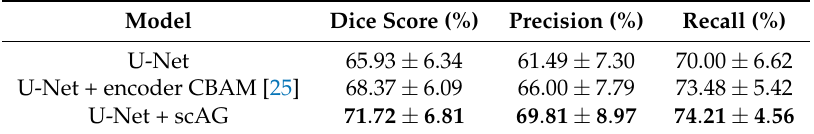
Table 7. Performance on the CVC-ClinicDB dataset by using the self-attention encoder feature (best results marked bold).